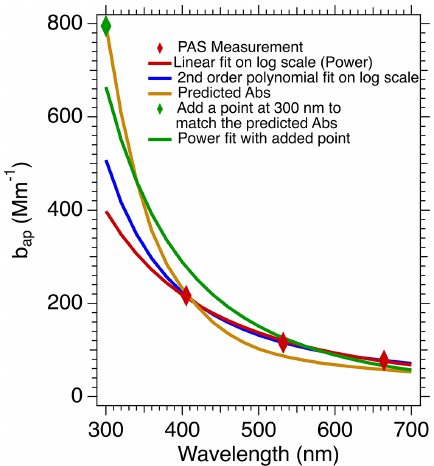
Figure 7. Comparison between the predicted absorption from the sum of BC and TS BrC ( b ap , predicted ,λ ) brown curve (and in Fig. 5a) and various fits to the PAS data (red diamonds). The red line is PAS data fitted with a line on a log–log scale, which is the typical power law fit, the blue curve is a second-order polynomial fit on log–log scale, and the green line is a power law with an added data point from b ap , predicted , 300nm at